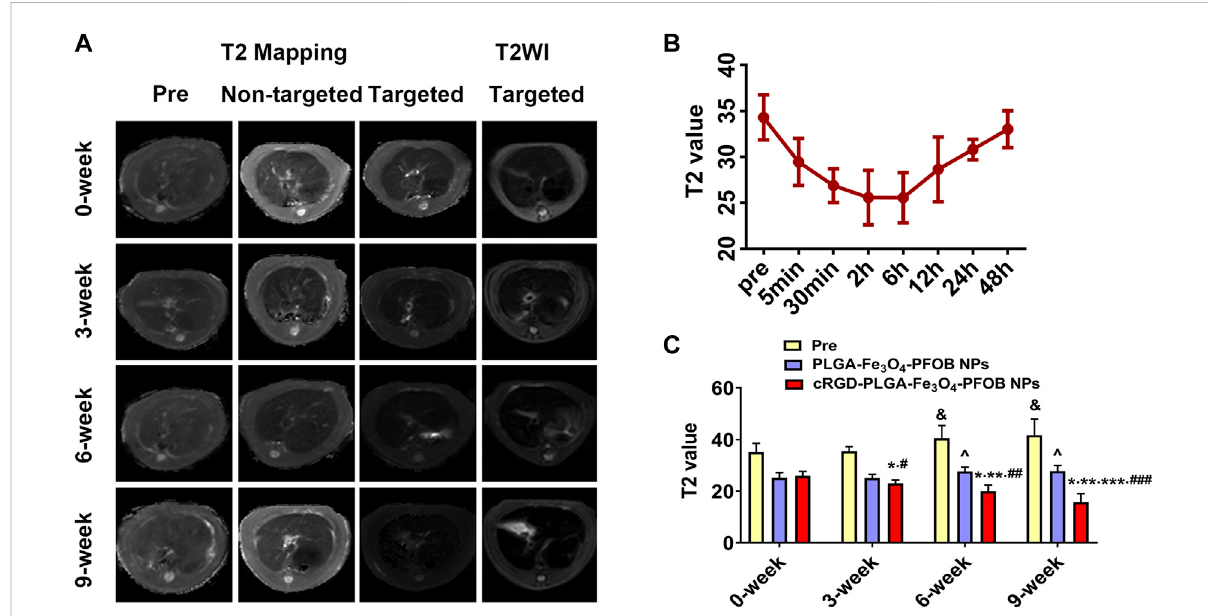
FIGURE 10 In vivo MR imaging. (A) MR images of liver before and after injection of targeted contrast agents (cRGD-PLGA-Fe targeted contrast agents (PLGA-Fe 3 O 4 -PFOB NPs). (B) T2 value of the liver parenchyma in the 0-week group within 48 h after injection of cRGD-